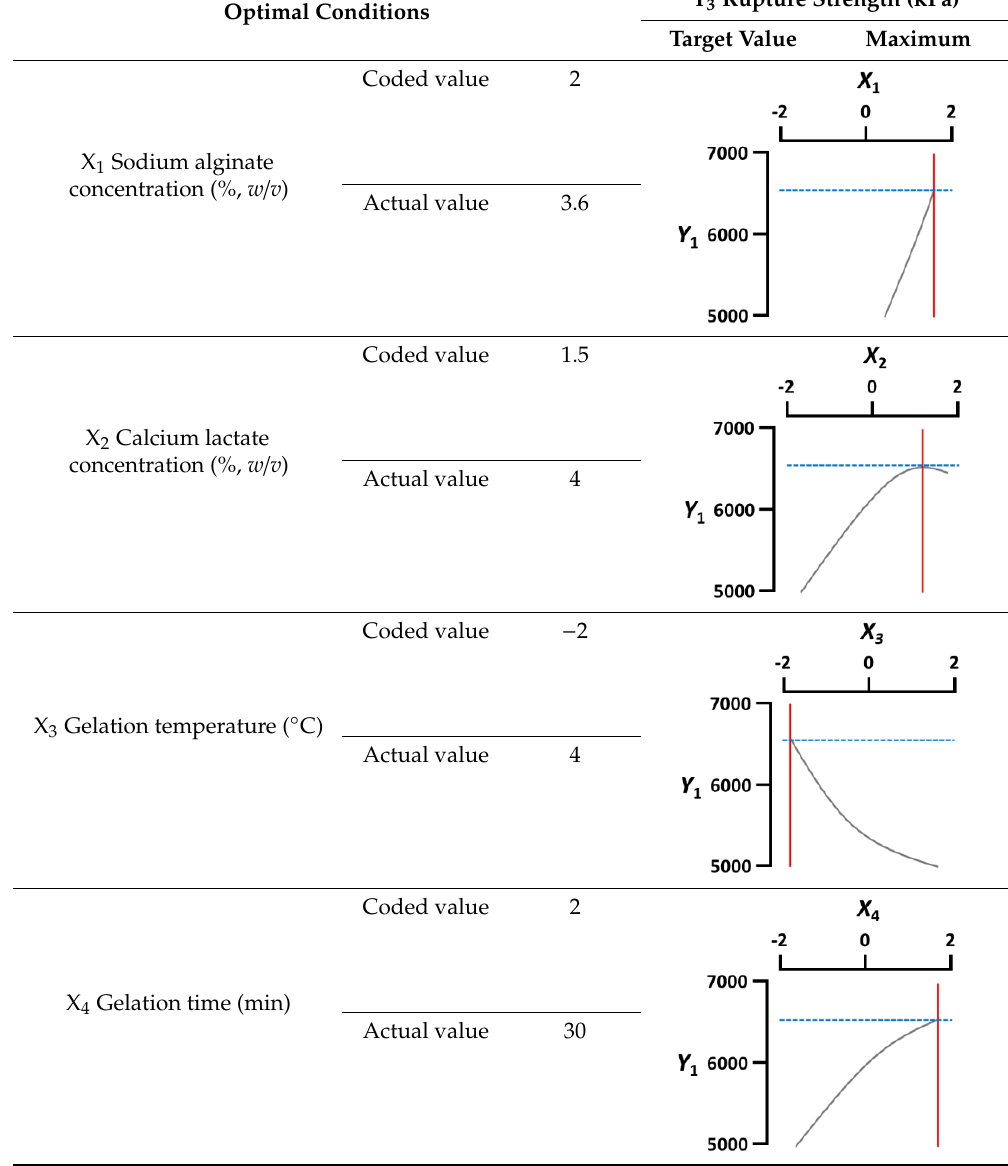
Table 7. The optimal conditions for preparing CAG beads with a maximum rupture strength.